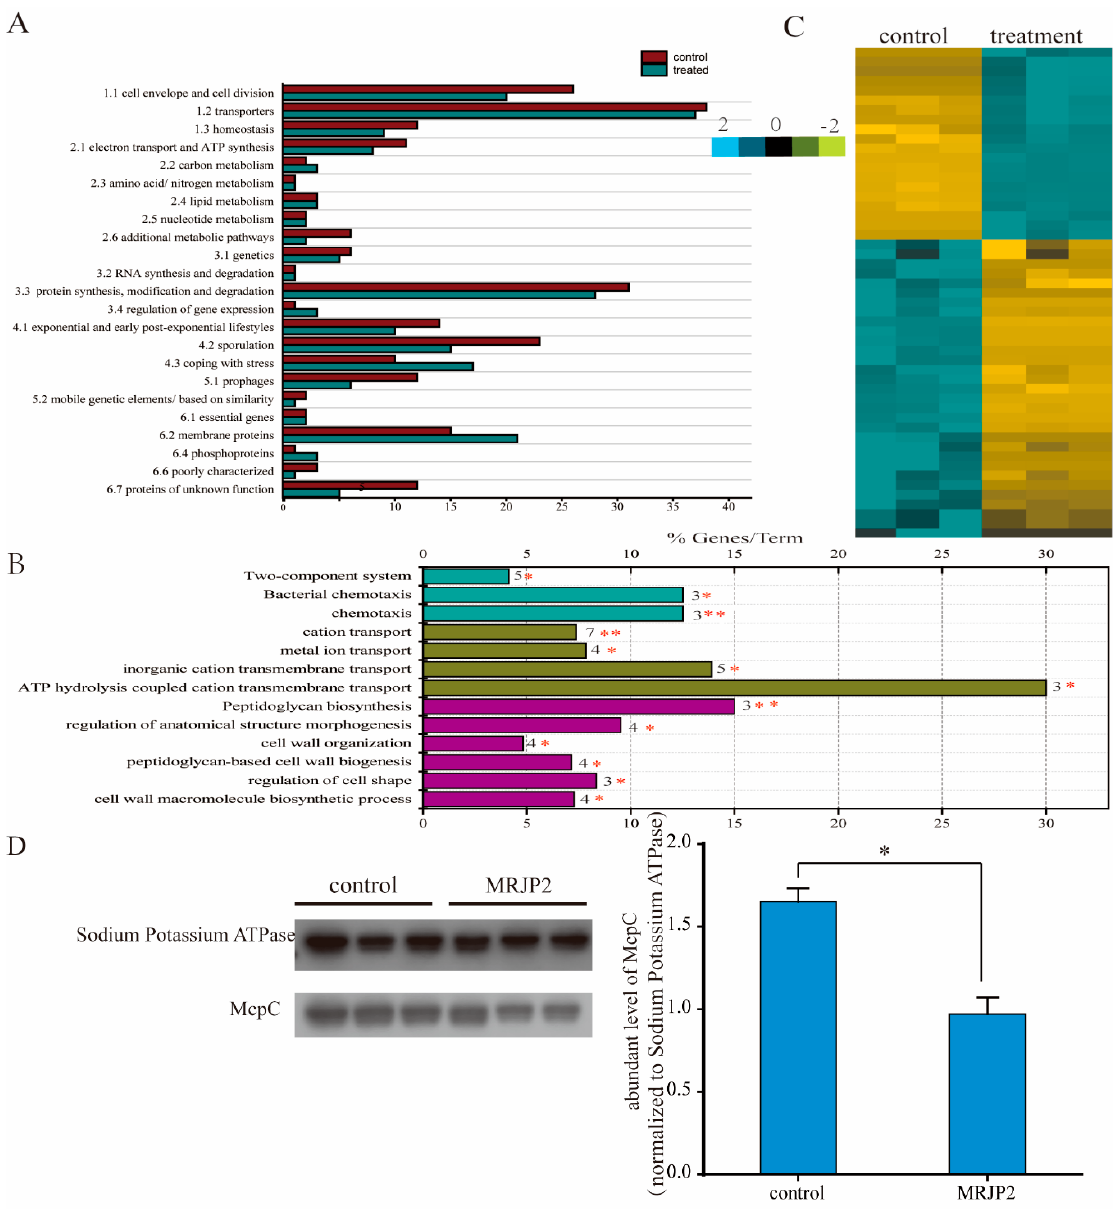
Figure 4. Qualitative and quantitative comparison of membrane proteins of Paenibacillus larvae before and after treatment with N-glycosylated major royal jelly protein 2 (N-MRJP2). ( A ) Categorization of proteins according to SubtiWiki based on the sequence alignment using BlastP against Bacillus subtilis database downloaded from UniProt with the e-value < 1.0 × 10 − 10 . ( B ) Enriched functional groups of the differentially expressed membrane proteins. % genes/Term represents the proportion of genes enriched in corresponding functional groups. The bars with the same color represent they belong to the same functional group. The numbers stand for the genes enriched to the corresponding functional group. “*”, p < 0.05; “**”, p < 0.01. ( C ) Unsupervised hierarchical clustering of the differentially expressed membrane proteins before and after the treatment with N-MRJP2 (fold changes > 2, p < 0.05). The high- and low-intensity level of membrane proteins are indicated by light blue and darkgolden color code. ( D ) Western blot analysis of the relative expression level (fold change) of methyl-accepting chemotaxis protein (McpC) before (control) and after (MRJP2) the treatment with N-glycosylated MRJP2. Sodium potassium ATPase is used as reference control.